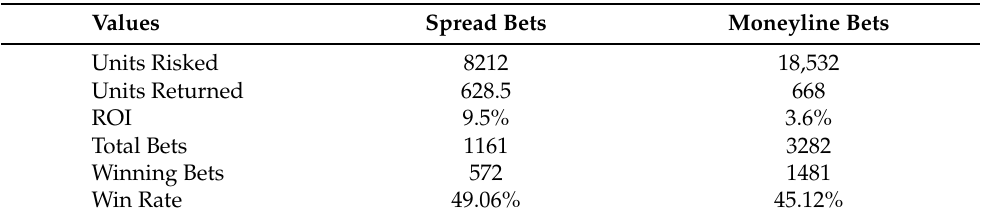
Table 8. WoC Bets: Risk, Return and Win Rate (Accuracy) for Spread and Moneyline